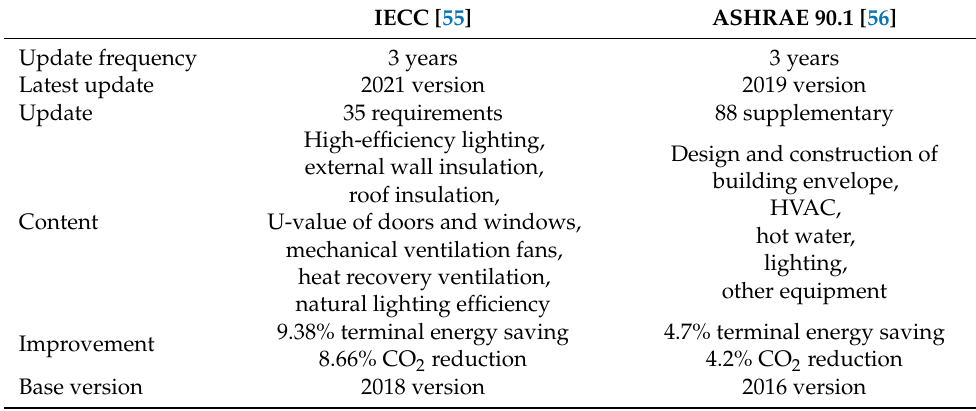
Table 2. IECC and ASHRAE 90.1 standard improvements compared to their last